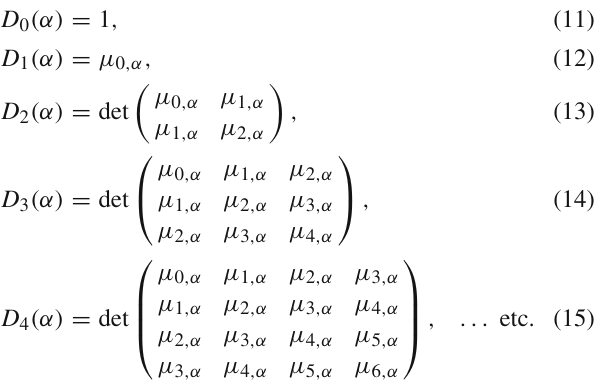
Fig. 2 Model-independent Lévy expansion results from fits to elastic pp scattering data by the TOTEM Collaboration at the LHC energy of √ s = 7 TeV. Although the fit quality is marginal, CL ≈ 0 . 02%, the fitted curve follows the data so closely that we decided to interpret the fit parameters, noting that the errors on the best values of the parameters are likely